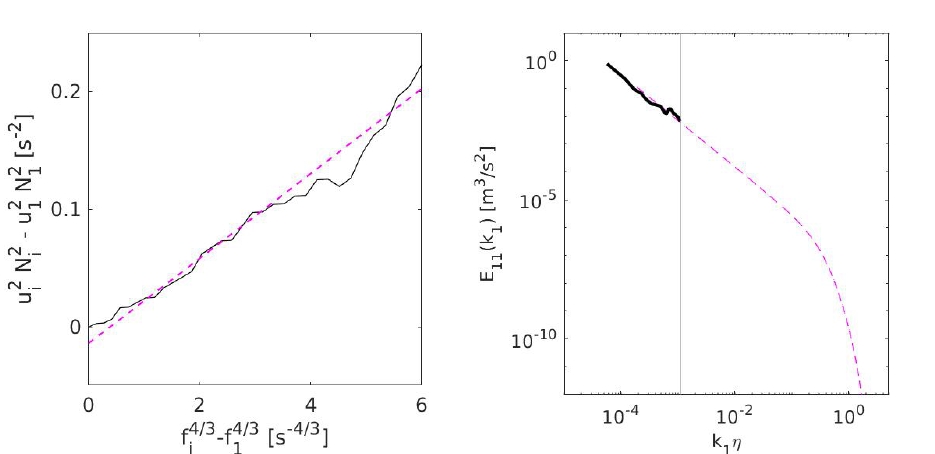
Figure 2. Left : Exemplary number of zero-crossing scaling calculated from experimental POST data, for cut-off within the inertial range, see Equation (9), dashed magenta line indicates the best fit-line. Right : Power spectra of a signal with spectral cut-off, magenta line indicates reconstructed part of the